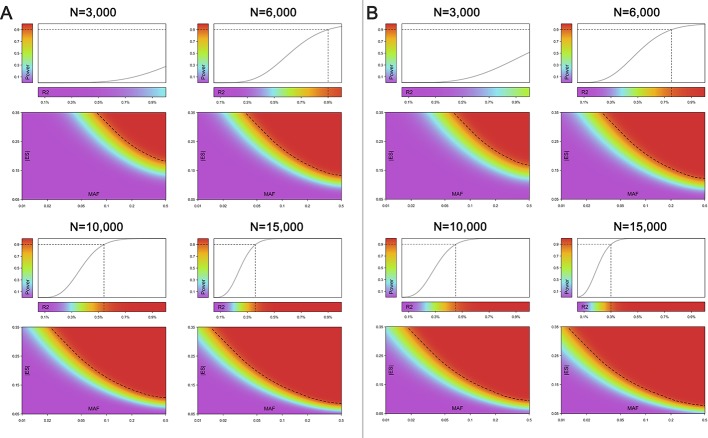
Power analysis.The power of association tests under a variety of sample sizes (N = 3,000, 6,000, 10,000 and 15,000) with varied proportions of explained phenotypic variance (R2), absolute effect size (|ES|) and minor allele frequency (MAF) are investigated at (A) our study-wide significant level (1.2 × 10−9; and (B) our study-wide suggestive significance level (5 × 10−8). Power and R2 are indicated by different colors. The dashed line represents the distribution of 90% power value. For example, under the sample size of 10,000, our study has 90% power to detect suggestive significant SNP explaining at least 0.43% of the phenotypic variance (R2).